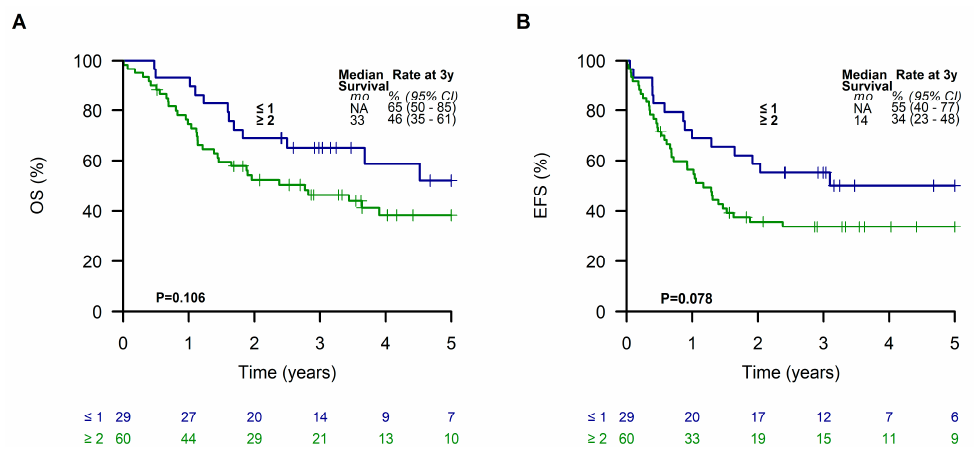
Figure 5. Overall survival ( A ) and event-free survival ( B ) of patients receiving a metronomic long- term maintenance therapy according to the Oberlin risk groups.